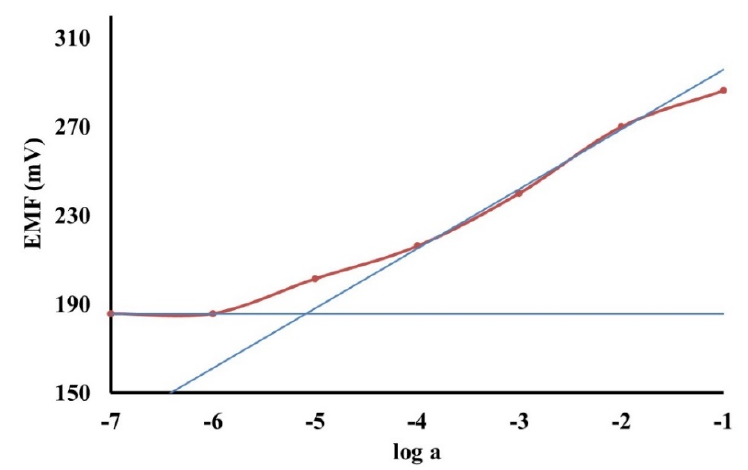
Figure 3. Calibration curve of the membrane electrode containing crown ether ionophore rac - 4 and 2-nitrophenyl-octyl ether (o-NPOE) as plasticizer with lead(II) acetate in aqueous solution. The electrode gives a near-Nernstian response to lead(II) ions with a slope of 26.9 mV/decade in